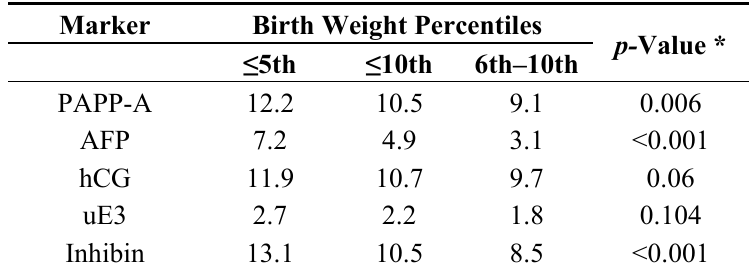
Table 1. Detection rate (%) at a 5% false positive rate based on definition of IUGR using Birth Weight